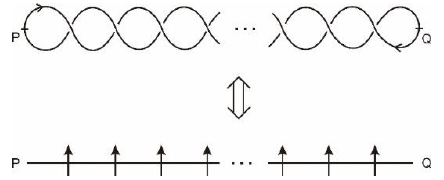
Figure 4. A braid is mapped to a spin-chain lattice.